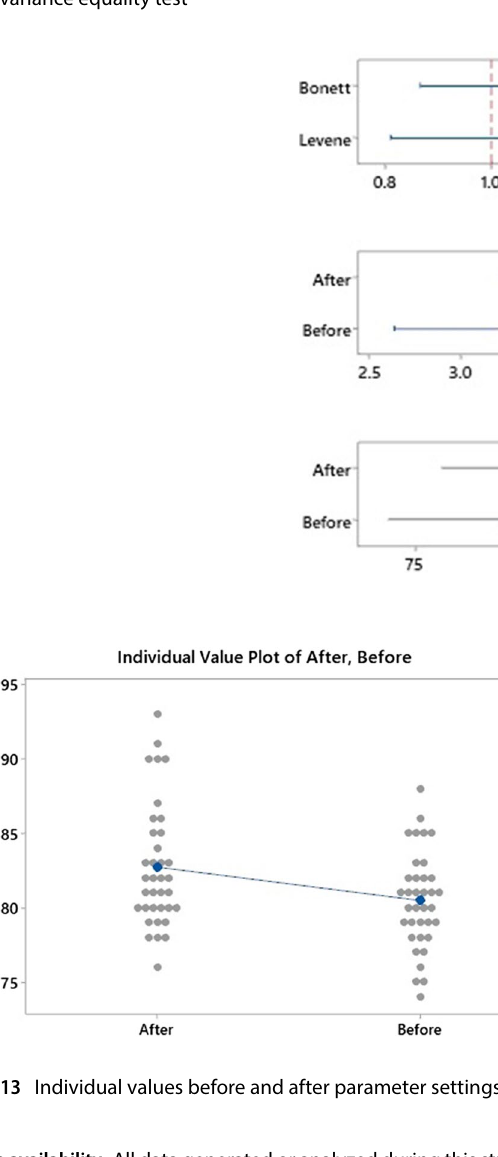
Fig. 12 The graphical results of the variance equality test